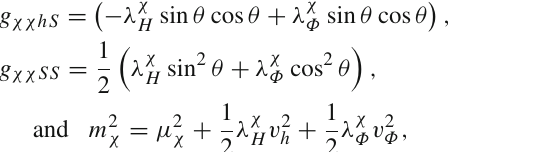
while the blue, magenta and purple regions represent the current exclu- sionbyXENON1TandtheprojectedsensitivitiesoftheXENON1Tand LZ, respectively. The details concerning the assignations of the model parameters are discussed in the main